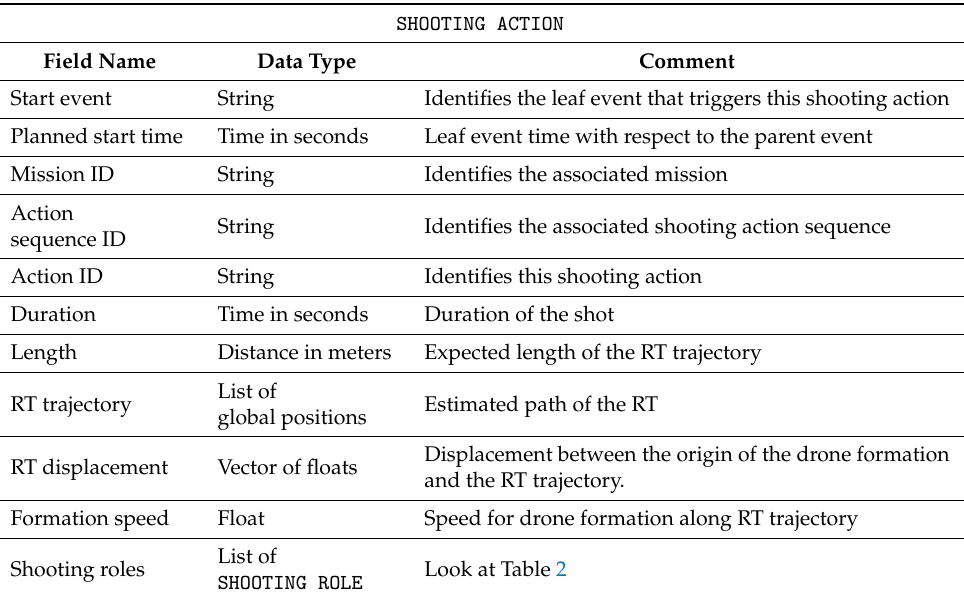
Table 1. Structure for the data type SHOOTING ACTION